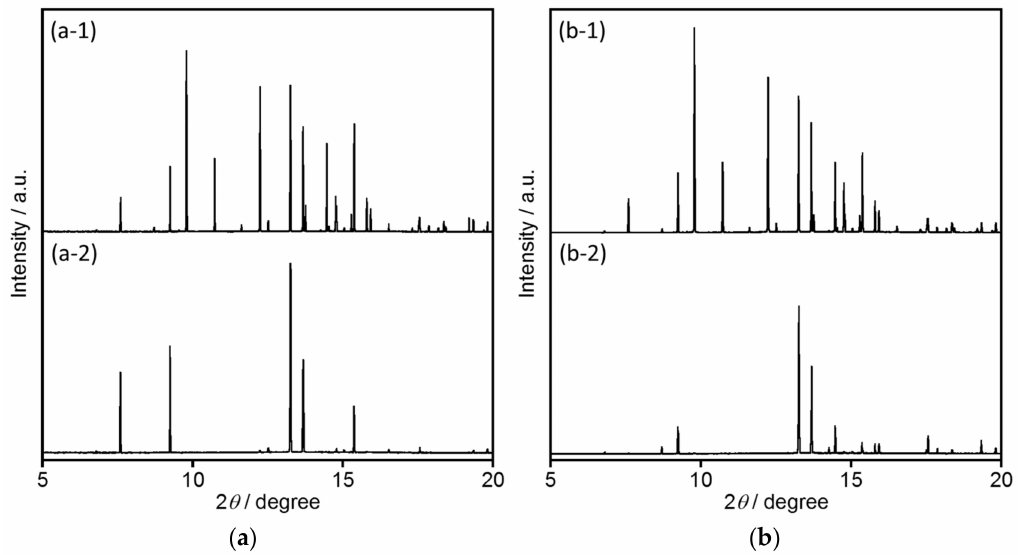
Figure 7. Synchrotron X-ray powder diffraction patterns of ( a ) [EMIM][PF 6 ] and ( b ) EuL in [EMIM][PF 6 ]. ( a-1 , b-1 ) before and ( a-2 , b-2 ) after heating at 70 ◦ C ( λ = 1.017593